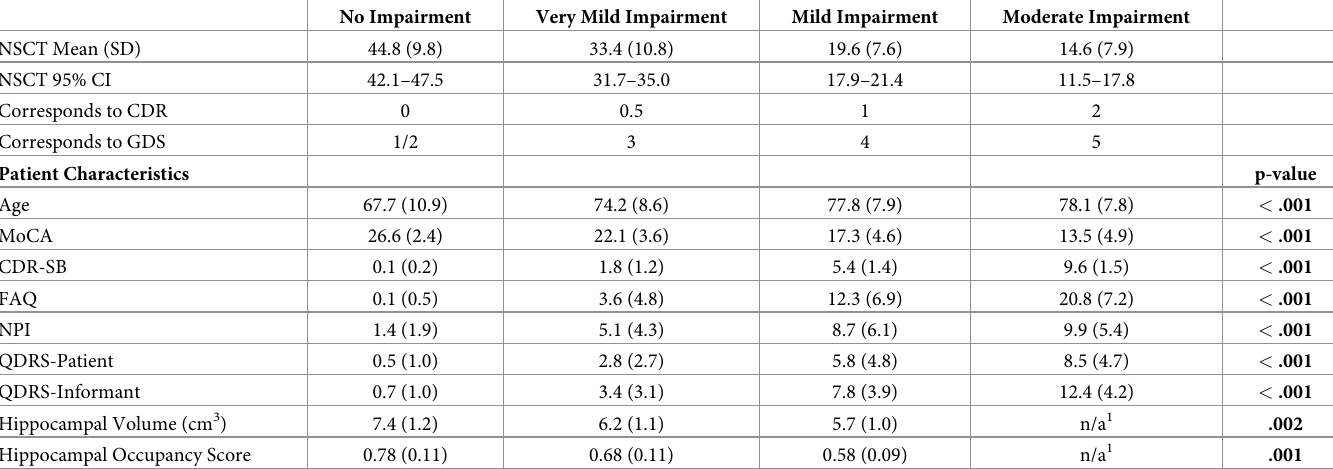
Table 5. Clinical profiles of Number Symbol Coding Task